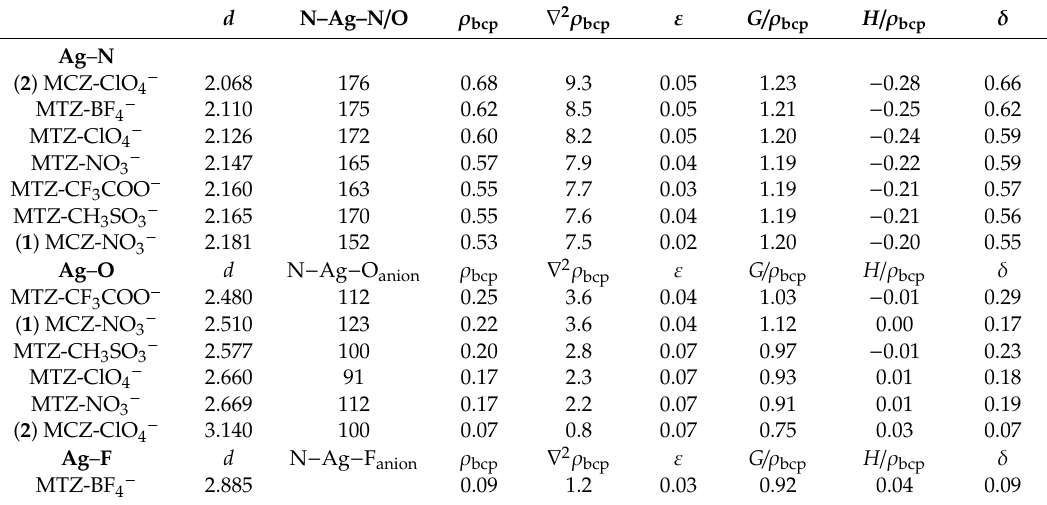
Table 5. Quantum Theory of Atoms in Molecules (QTAIM) bonding indicators for Ag − N and Ag − O / F for silver(I) complexes with metronidazole and miconazole ligands and di ff erent counter ions.